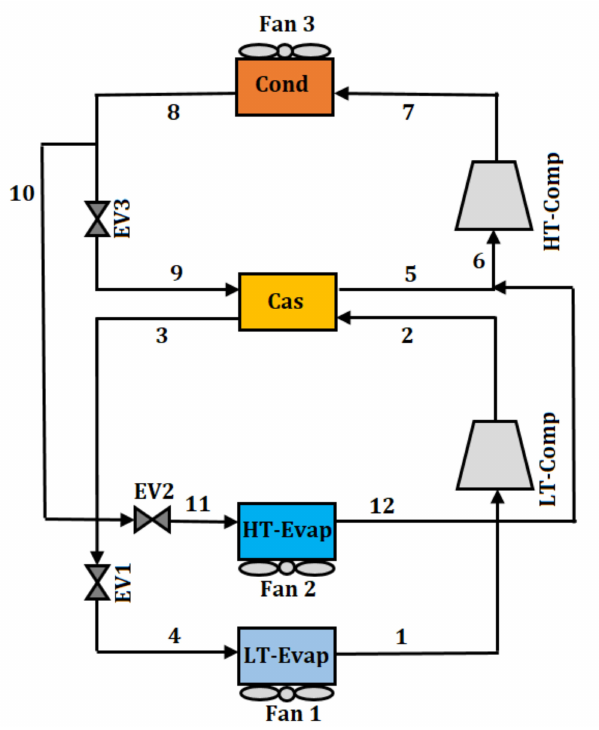
Figure 1. Simplified schematic layout of the dual-evaporator cascade vapor compression refrigeration